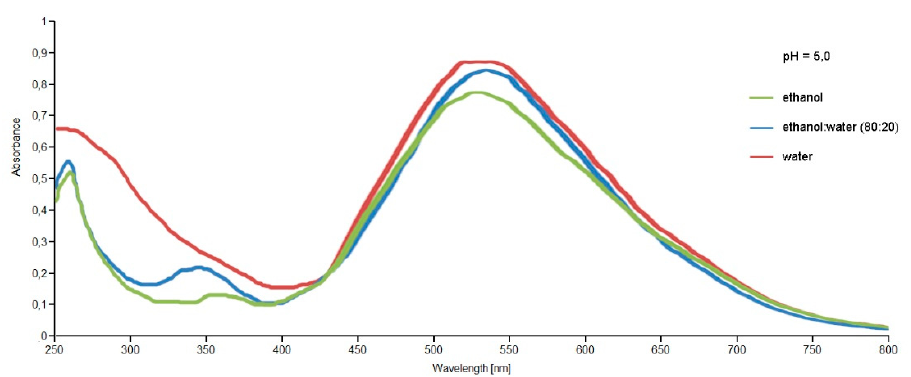
Figure 5. UV-VIS spectra, between 250–800 nm, of the Opuntia ficus-indica (L.) Miller extracts obtained with the Extractor Naviglio ® in different solvent conditions and at the same pH value.